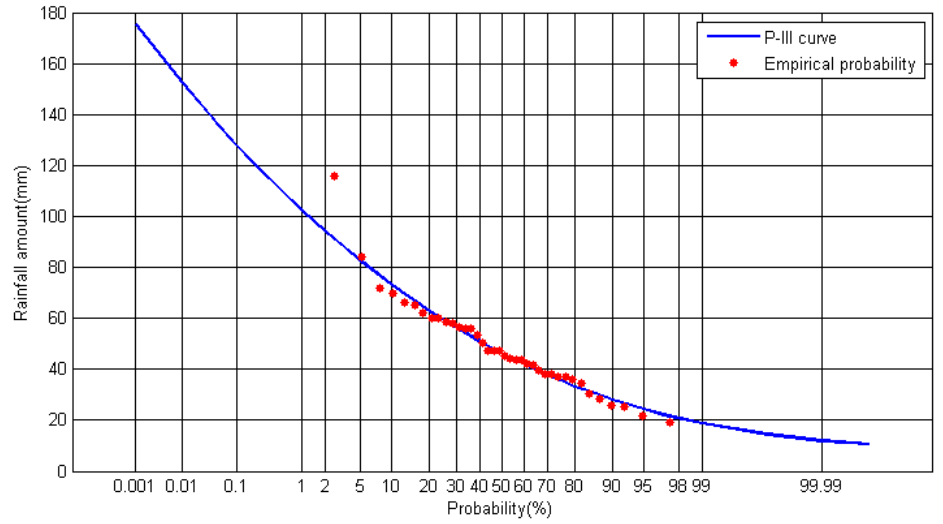
Figure 3. Fitted P-III curve and empirical probability points for the areal rainfall sequence. Table 1. Design areal rainfall amount with different return periods.